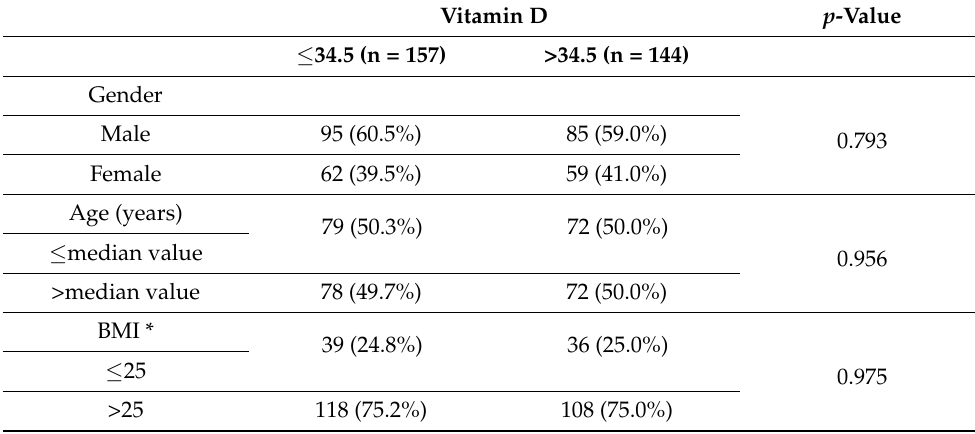
Table 2. Correlation between Vitamin D Levels and the Clinical characteristics and Demographics of Study